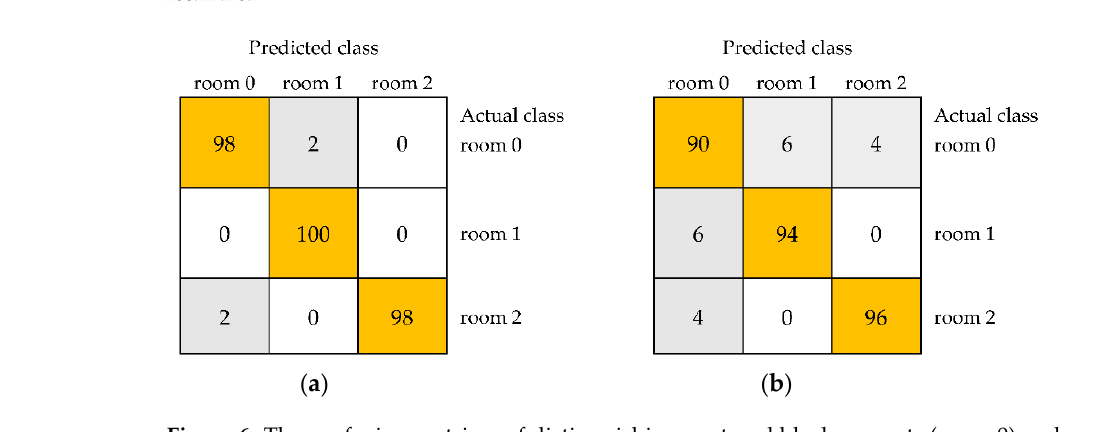
Table 6. The performance metrics of the classification of unstored black currants and black currants stored in the refrigerator (one and two weeks) based on models developed based on selected tex- tures from color space XYZ using different algorithms. Algorithm